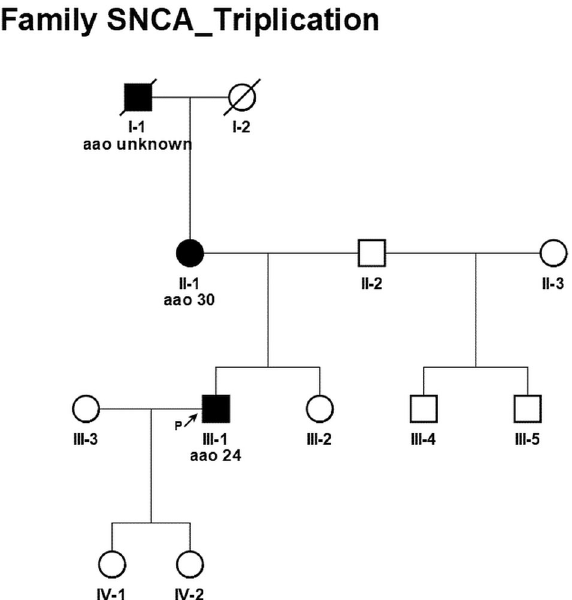
Fig. 1 Pedigree of the SNCA Triplication